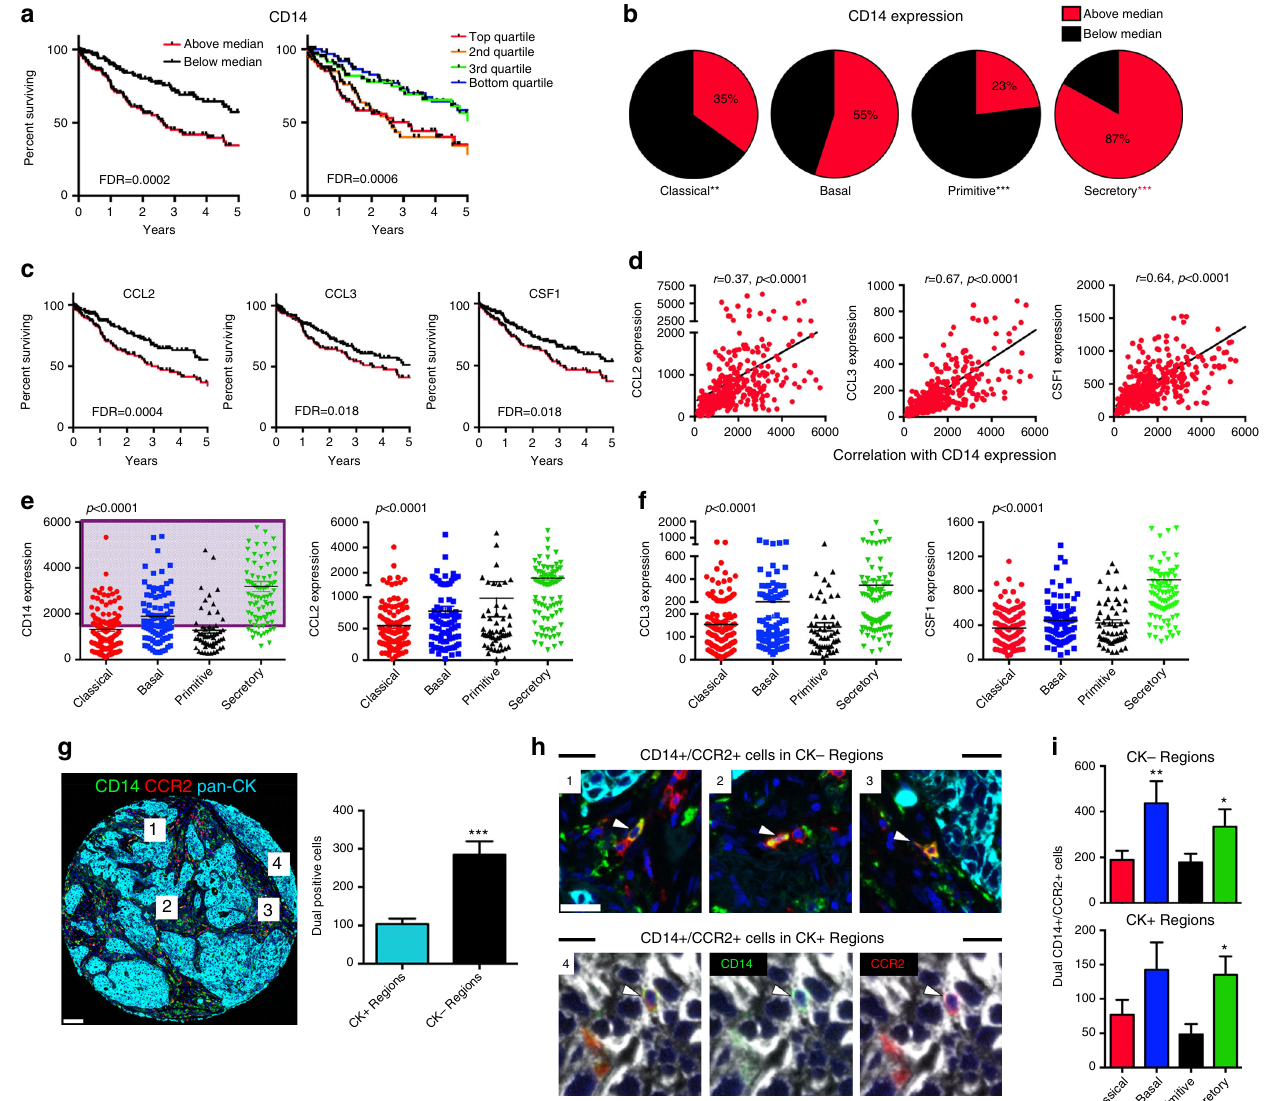
Fig. 2 In fl ammatory monocytes associate with survival in LUSC. a Kaplan – Meier plots of overall survival in lung squamous carcinoma (LUSC) patients split by median (left, p < 0.0001) and quartile (right, p = 0.0006) expression levels of CD14. P -values are obtained with the log-rank test; FDR were calculated according to Benjamini and Hochberg. b Proportion of patients by mRNA subtype that have CD14 expression levels above (red) or below (black) the median CD14 expression level. Binomial tests for proportions were performed. (Black asterisks: signi fi cant enrichment below the median, red asterisks: Signi fi cant enrichment above the median). c Kaplan – Meier plots of overall survival in LUSC by expression levels of CCL2 ( p = 0.001), CCL3 ( p = 0.018) and CSF1 ( p = 0.015) expression. d Pearson ’ s correlations of CCL2, CCL3, and CSF1 chemokines versus CD14 (gene expression). e Dynamic range of mRNA expression of CD14 and CCL2 for each LUSC mRNA subtype. P -values were obtained with analysis of variance. The purple shading for CD14 expression represents samples in the ‘ IM-rich subset ’ (above the median CD14 expression level). f Dynamic range of mRNA expression of CCL3 and CSF1 by LUSC mRNA subtype. g Representative multiplex IHC for CD14 (green), CCR2 (red) and pan-cytokeratin (light blue) in a LUSC tumor sample, and enumeration of CD14 + /CCR2 + cells in CK + and CK- regions. #1-3 represent CK- regions, #4 represents a CK + region. Scale bar 100 μ m. h Representative dual CD14 + /CCR2 + cells (white arrows) in CK- (#1-3) and CK + (#4) regions. Note: CK + region shown in white channel to more easily appreciate green and red. Scale bar 25 μ m. i Enumeration of CD14 + /CCR2 + cells in CK- and CK + regions by mRNA subtype. Classical ( n = 14), Basal ( n = 9), Primitive ( n = 6) and Secretory ( n = 12). p -values were obtained with Student ’ s t-test in comparison to the Classical subtype. * P < 0.05, ** P < 0.01, *** P < high CD14 expression is related to other CD14-expressing Given the recent advances in immunogenomic pro fi ling to immune in fi ltrates, such as TAMs, DCs, myeloid-derived sup- uncover immune in fi ltrates in tumors with high fi delity 27,28 , we applied a modi fi ed ‘ Immunome ’ signature across all LUSC TCGA pressor cells (MDSCs) or neutrophils 20,26 . We sought to deter- tumors based on a median CD14 expression level threshold mine whether we could re-classify mRNA subtypes according to (Supplementary Data 7). Classical tumors were predominately the levels of CD14 expression, the degree to which leukocyte cell represented in the low ( < median) CD14 expression cohort, while types correlate with CD14 expression, and how tightly these cell Secretory tumors were predominantly in the high ( ≥ median) type densities correspond with poor survival.